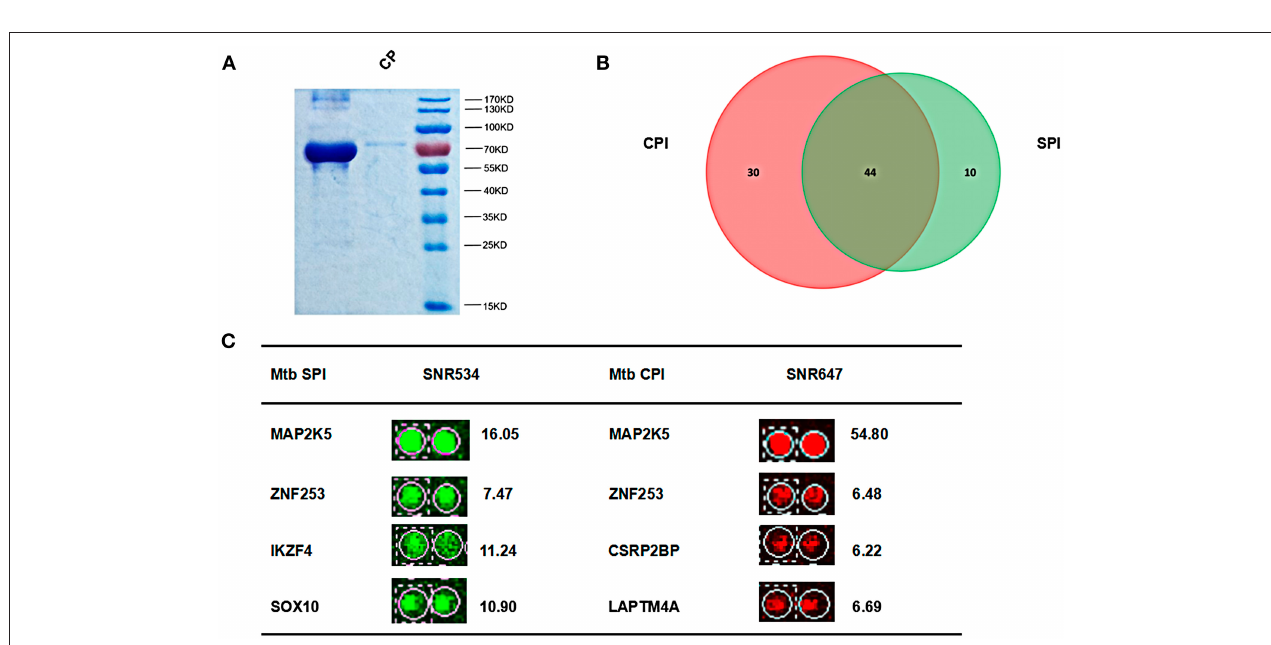
FIGURE 2 | Identification of Mtb SPI and CPI on a human proteome microarray. (A) Extraction and purification of Mtb SP and CP. The proteins were detected by SDS-PAGE followed by coomassie brilliant blue staining. (B) The Venn diagram of Mtb SPI (green) and CPI (red). (C) Representatives of the newly identified Mtb SPI and CPI. The cutoff for calling positive candidates was set as signal-to-noise (SNR) ratio > 2.0. Experiments were performed in two replicates. of CPI. The top three classes are cellular process